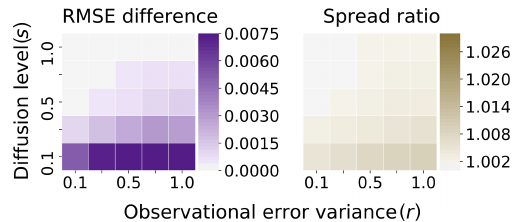
Figure 7. Truth: Taylor (cid:49) t = 10 − 3 . Ensemble: Euler–Maruyama (cid:49) e = 10 − 3 . Difference in RMSE/ratio of spread with benchmark Fig. 5.